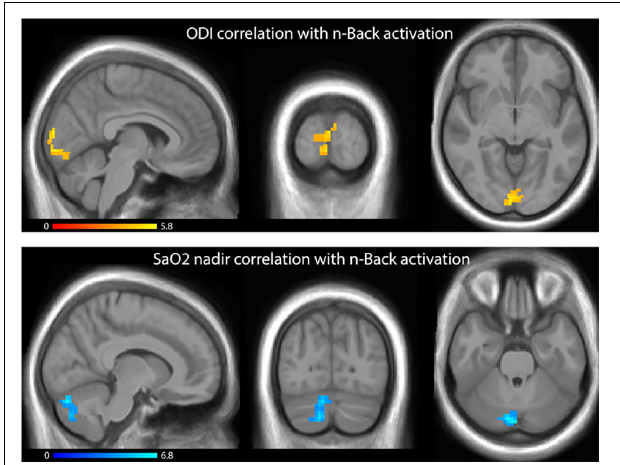
FIGURE 3 | Top: Statistical parametric map showing, in OSA patients, regression of ODI on beta values from the n-Back task regressors; increasing ODI values were associated with increased activation. Bottom: Statistical parametric map showing, in OSA patients, regression of SaO 2 nadir on beta values from the n-Back task regressors; decreasing SaO 2 values were associated with increased activation. SPMs are feature thresholded at p < 0.001, followed by family wise cluster thresholding at p <